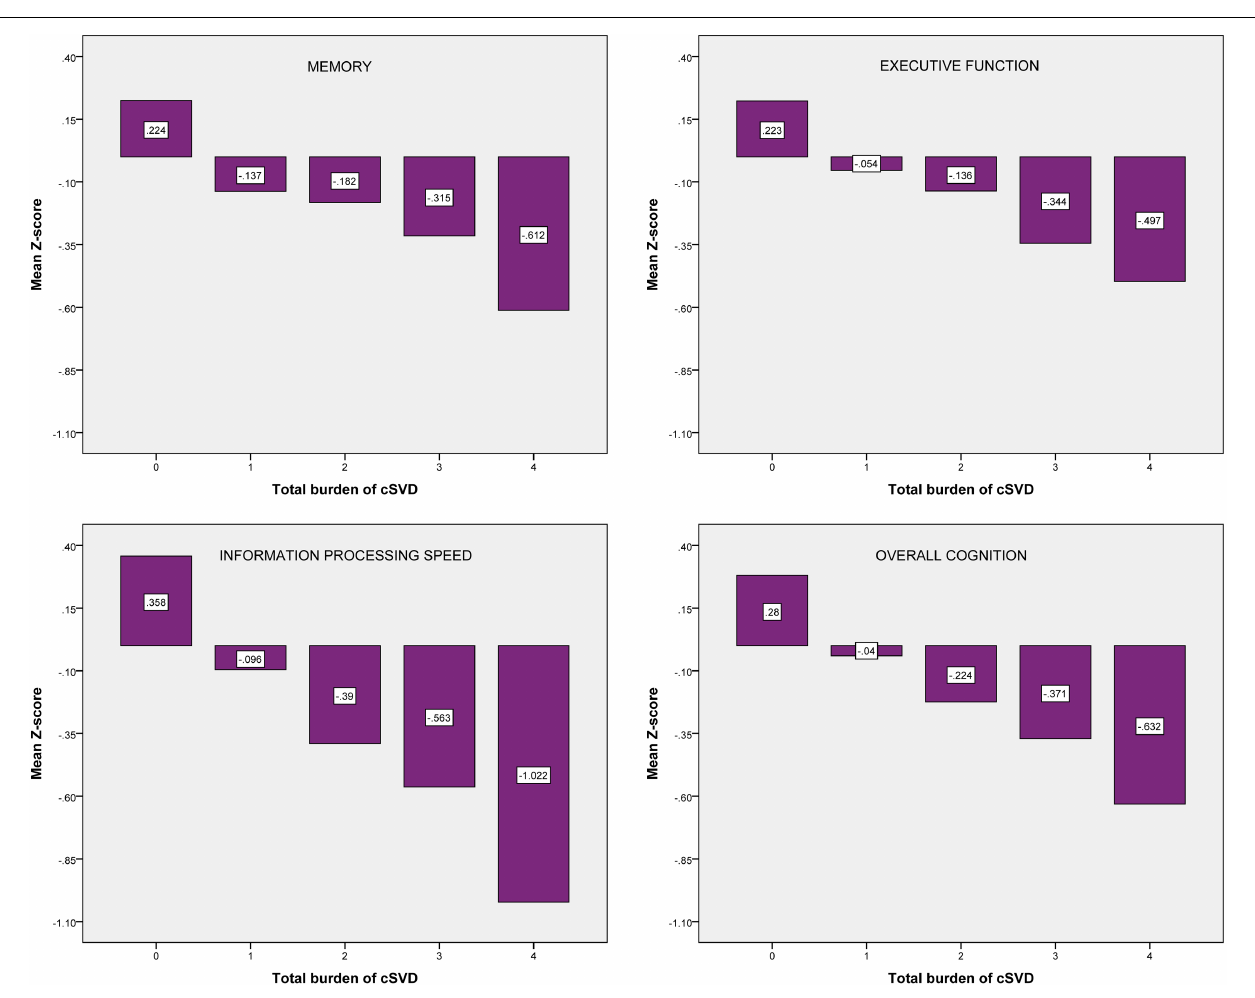
FIGURE 2 | Mean Z -scores on each of the cognitive domains, stratified by cSVD category . cSVD, cerebral small vessel disease.